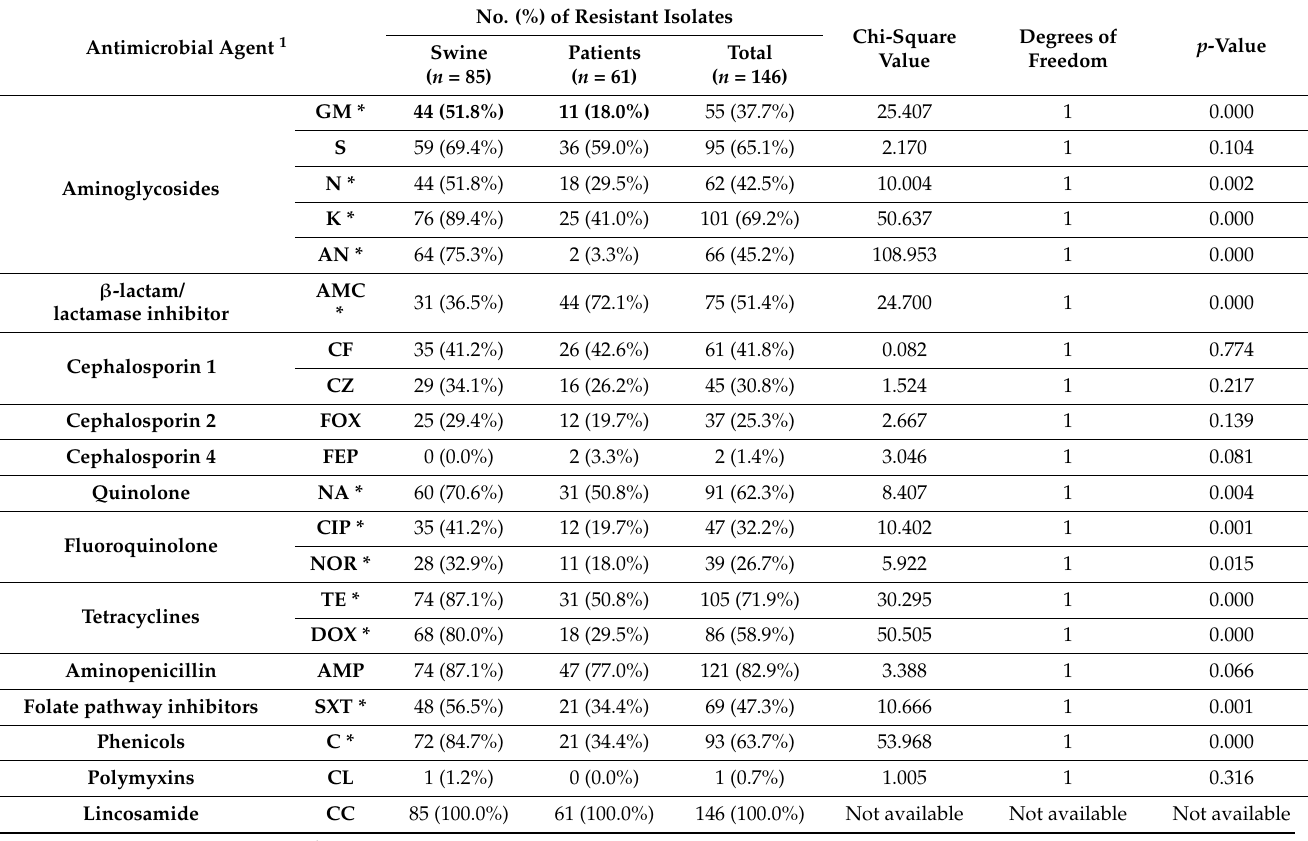
Table 2. Antimicrobial resistance of Escherichia coli from diarrheic pigs and patients.